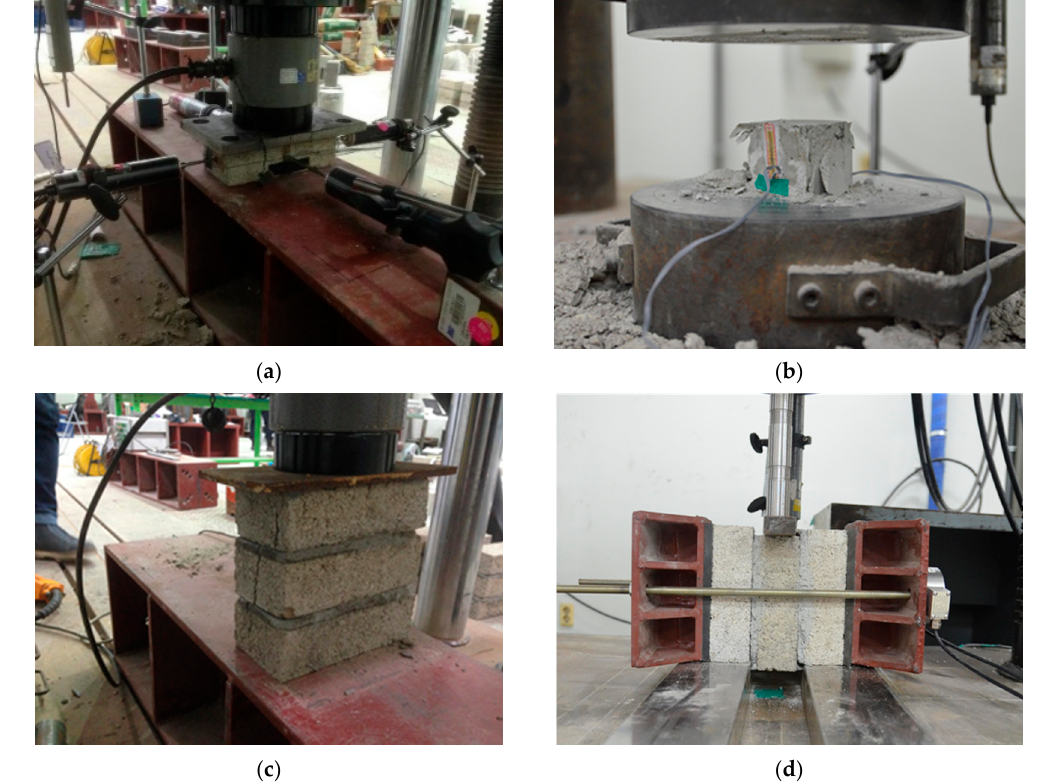
Figure 3. Material tests for masonry. ( a ) Masonry unit compression test. ( b ) Mortar compression test. ( c ) Masonry prism compression test. ( d ) Initial shear strength test.